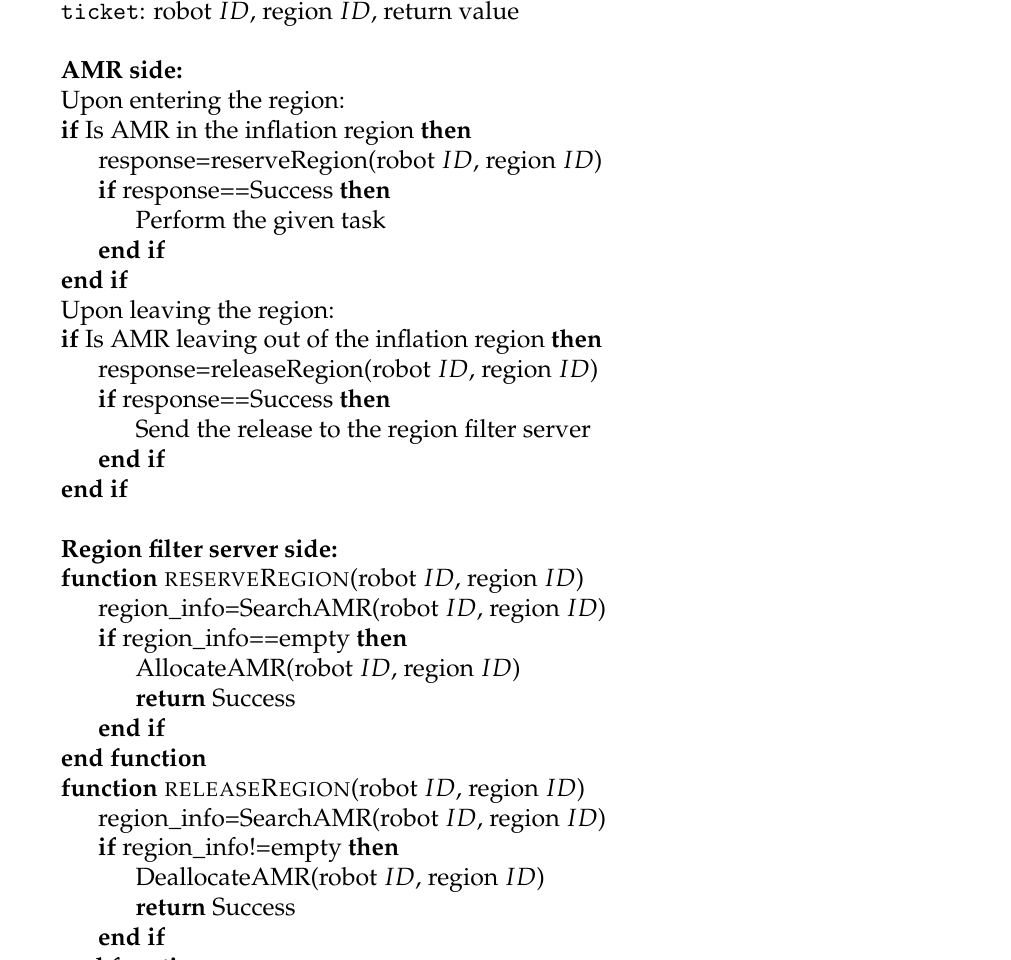
Algorithm 2 Region